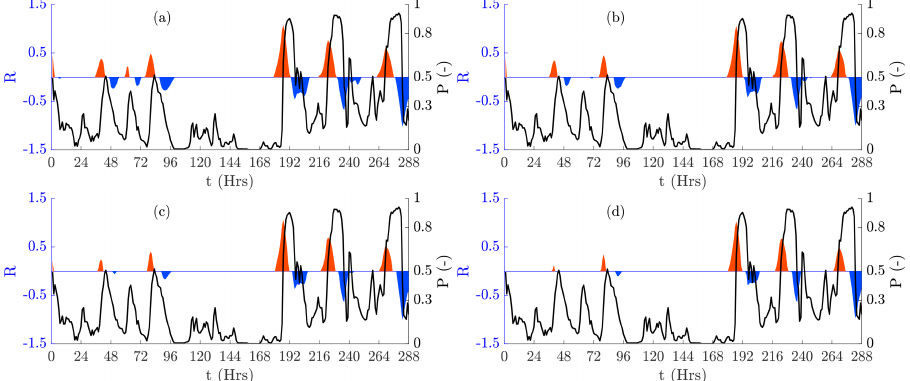
Figure 3. Detected normalized power ramps for the period of 20 to 31 May 2015 for a max = 20 with discrimination levels, W ∗ of: ( a ) 10% ( b ) 5% ( c ) 2% and ( d ) 1%. Ramp-up events are shown in red T and ramp-down evehnts in